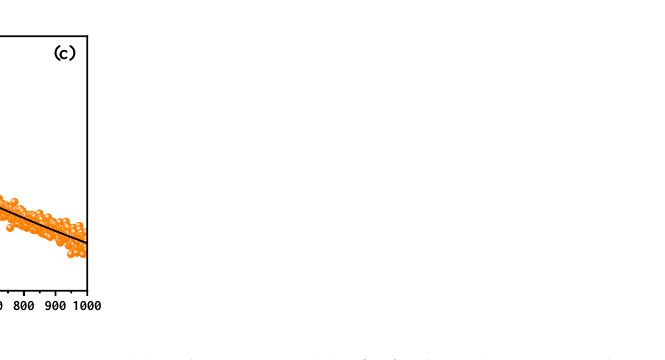
Figure 9. Comparison of the XRD pattern ( a ) and PL spectra ( b ) of a fresh CsPbBr 3 microplate and after 80 days of storage in ambient condition. ( c ) TRPL decay profile of the CsPbBr 3 microplate.